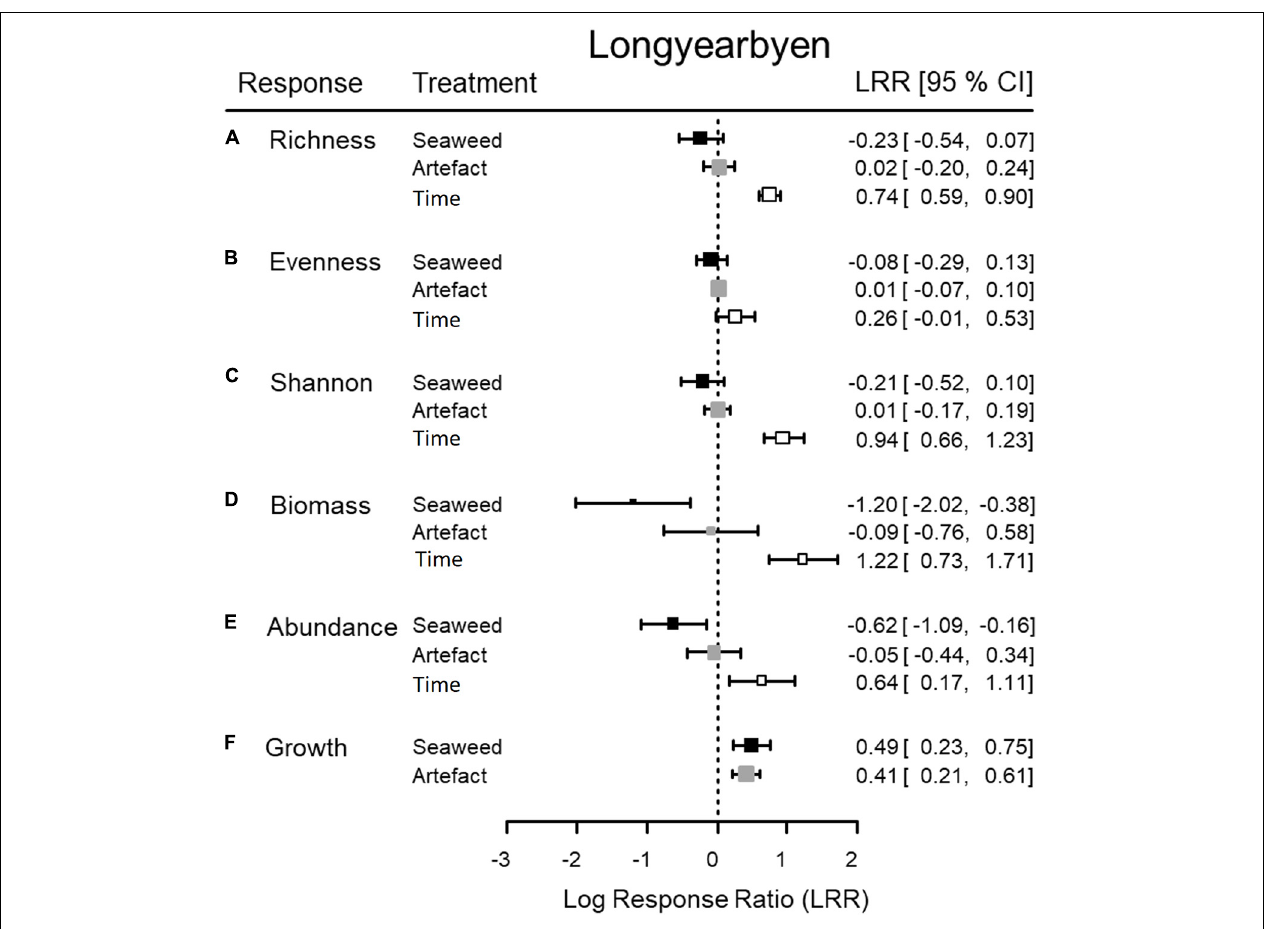
FIGURE 4 | Longyearbyen. Mean (square) and 95% confidence interval (CI, horizontal whiskers) of logarithmic response ratios (LRR) to quantify the effect of (i) seaweed presence (“Seaweed”; seaweed-covered vs. unmanipulated, black), (ii) procedural controls (“Artifact”; empty net-covered vs. unmanipulated, gray), and (iii) changes in unmanipulated areas over the course of the experiment (“Time”; unmanipulated end vs. unmanipulated start, white), for six (A–F) responses. Dashed line = level of no effect, n =